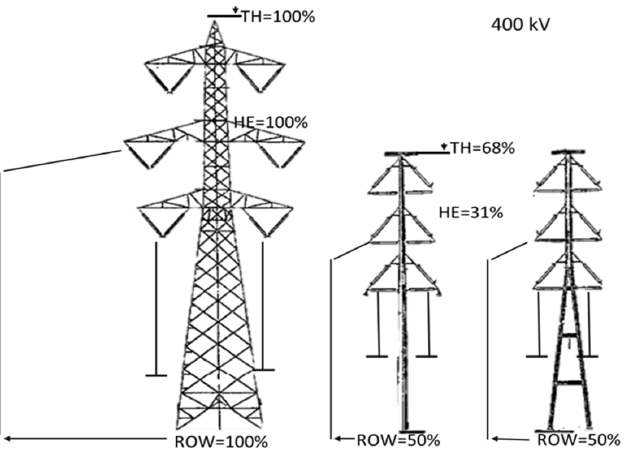
Figure 4. Comparison between compact lines and new lines for 400 kV [21].